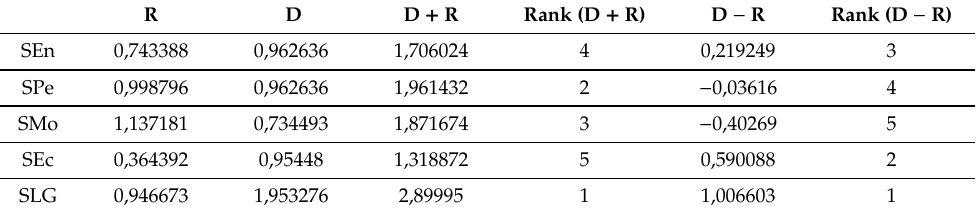
Table 8. The results and relation